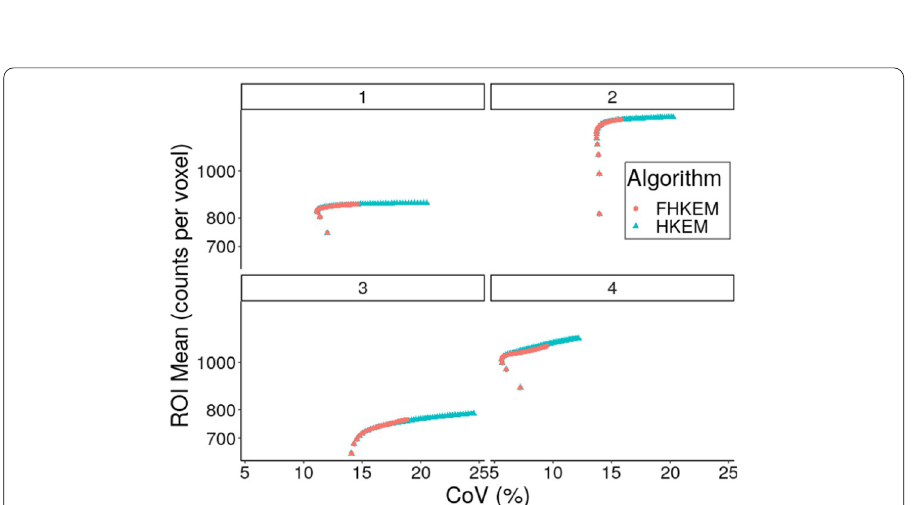
Fig. 6 Comparison between HKEM and FHKEM frozen at the 72nd sub‑iteration for the hottest lesion of 4 different patients. Comparison of the trade‑off between mean ROI value and